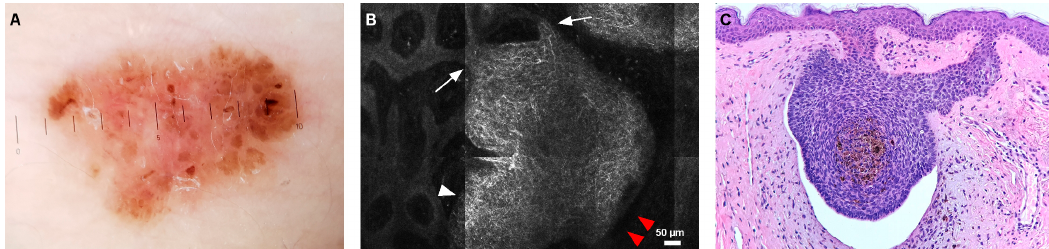
Figure 2. Superficial basal cell carcinoma. ( A ) Dermoscopy showing multiple, brown globules and dots, and leaf-like peripheral structures. ( B ) reflectance confocal microscopy (RCM) revealed the presence of sharply demarcated cords connected to the epidermis (white arrows), dark peritumoral clefting (red arrowheads), and peripheral palisading (white arrowhead), corresponding to the basaloid cords and aggregates seen on histopathology (hematoxylin and eosin (H&E) stain, magnification 4×) ( C ). Moreover, dendritic structures inside tumor islands and cords (14/24) were frequently seen.